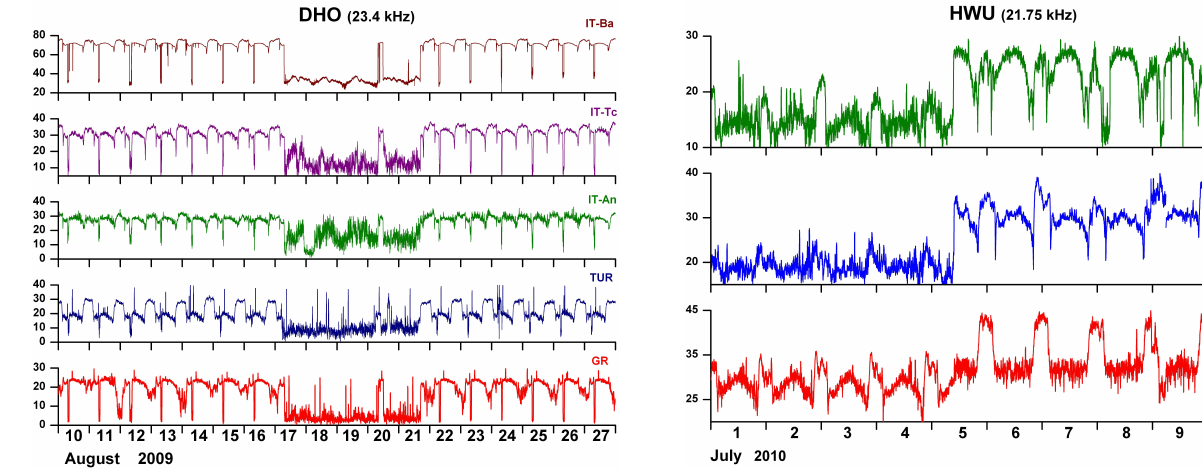
Fig. 6. Trends of the intensity of DHO (23.4kHz) radio signal sam- pled by IT-Ba, IT-Tc, IT-An, TUR and GR receivers during 10–27 August 2009. A drop in the values in the time interval 17–21 August clearly stands out.